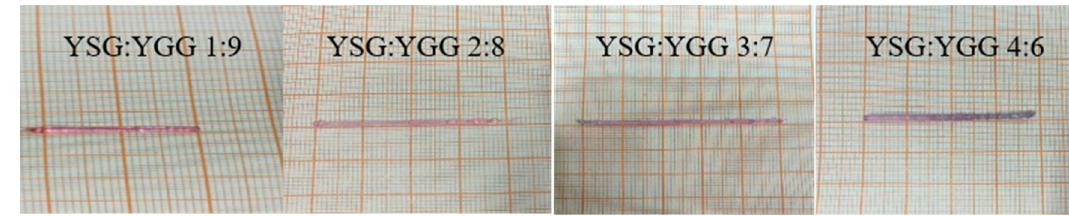
Figure 1. The different ratios of YSG:YGG crystal fibers, 1:9 to 4:6 from left to right.